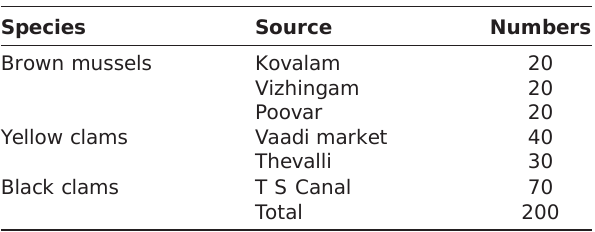
Table-1: Shellfish